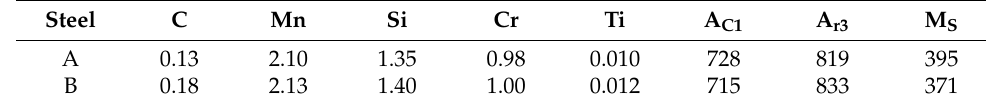
Table 1. Chemical compositions (wt%) and the phase transformation temperature ( ◦ C) of the investi- gated steels.